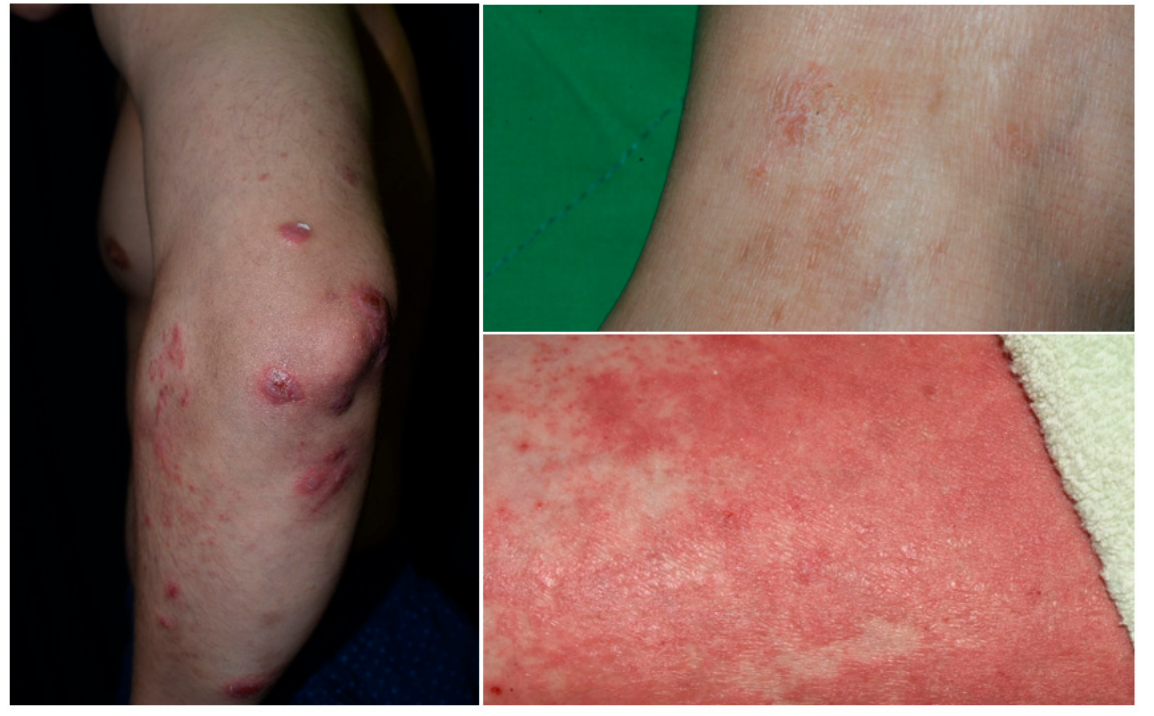
Figure 1. Psoriasis with overlapping features of eczema